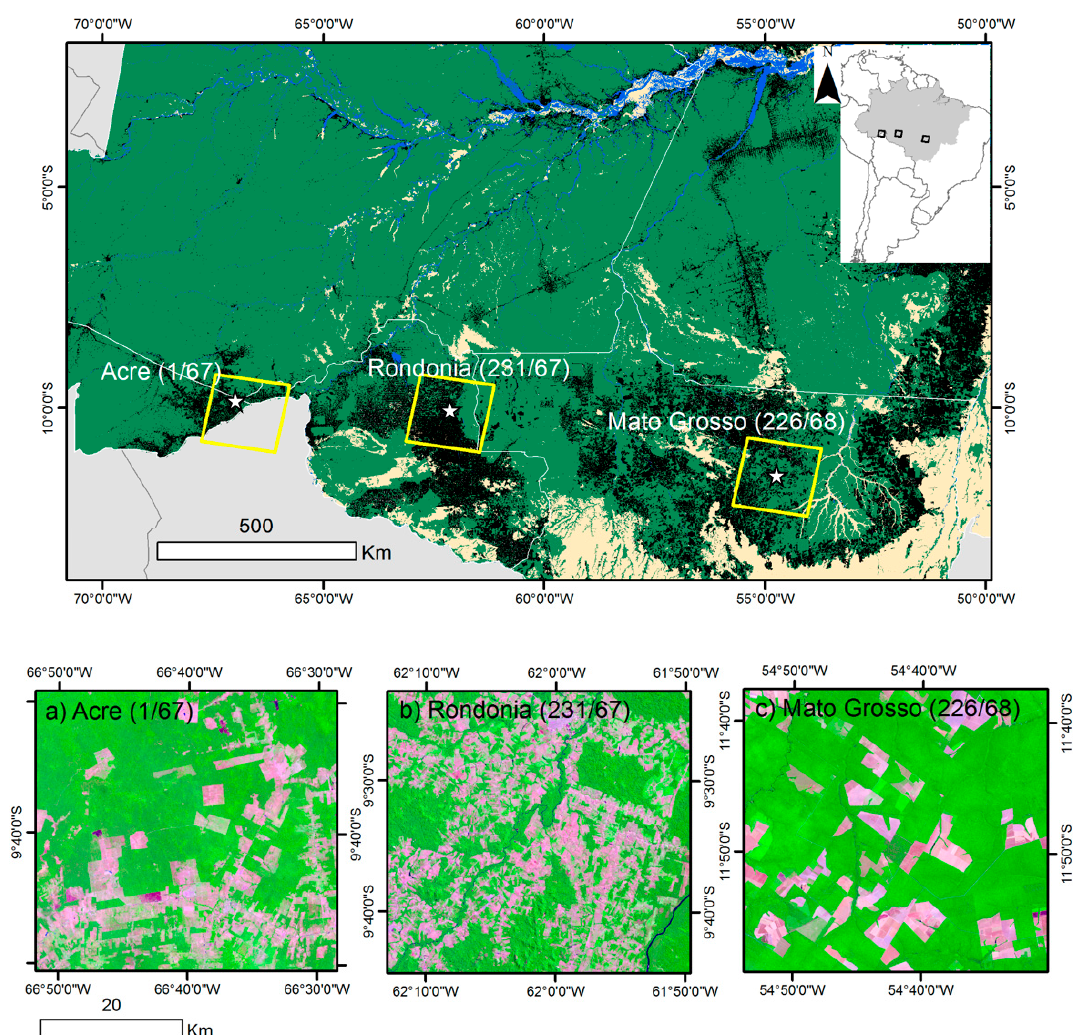
Figure 1. The three study sites within the State of ( a ) Acre (1/67); ( b ) Rondônia (231/67); and ( c ) Mato Grosso (226/68) in the southern Brazilian Amazon (Landsat false color composite images with bands 5, 4, and 3 in RGB).